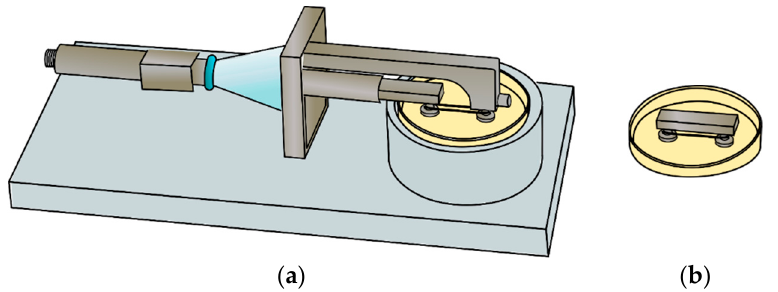
Figure 3. Diagram for collagen coating and cell seeding of the scaffold. ( a ) Mobile grip in aluminum base ‐ holder and in ( b ) static grip in petri dish.